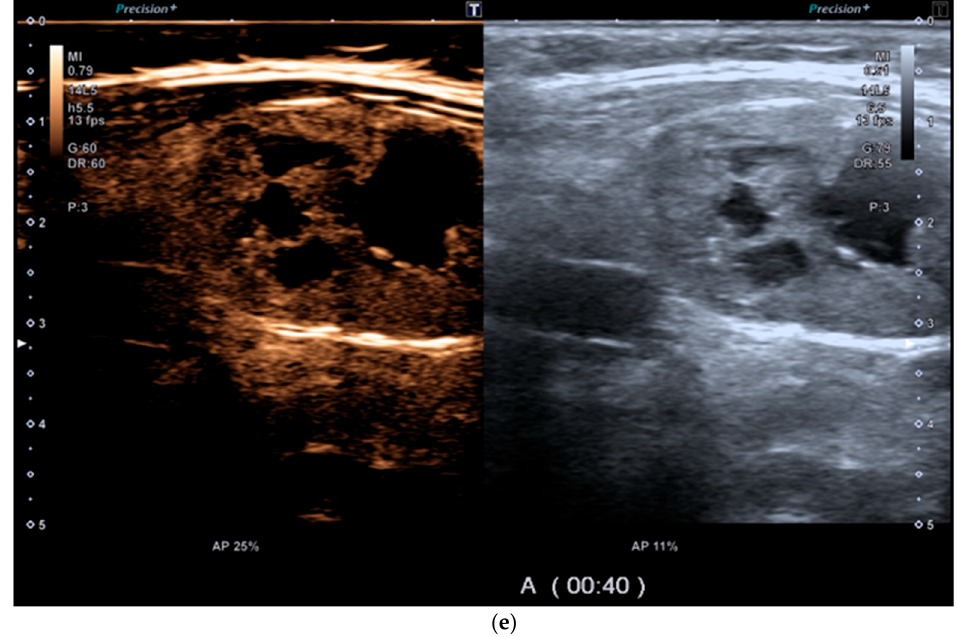
Figure 2. ( a ). At B-mode Ultrasound (US), an oval-shaped nodule with mixed ecostructure, some internal fluid areas and smooth margins, was identified (EU-TIRADS 3). ( b ). At color–Doppler US evaluation, the lesion appeared with internal and peripheral vascularization (pattern III). ( c ). At Strain Ratio Elastography (SRE) evaluation, the lesion appeared soft (SR 1.13). ( d ). At Shear Wave Elastography (SWE) evaluation, the lesion appeared soft (2.24 m/s). ( e ). At CEUS evaluation, the lesion appeared solid and richly vascularized, similar to the surrounding thyroid parenchyma without wash-out. At histology, the lesion was confirmed to be a follicular hyperplasia. Table 1. Pros and cons of each MPUS method and molecular test. PROS